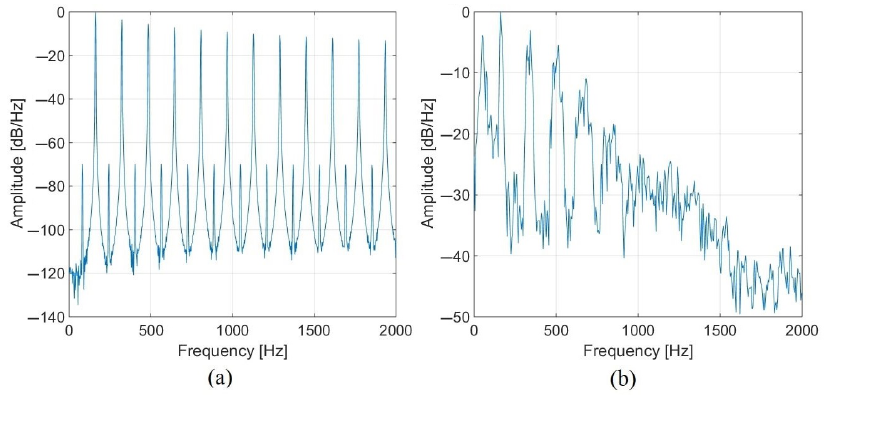
Figure 3. Power Spectral Densities of ( a ) the simulated drone signal provided by the model and ( b ) the real drone signal, both with f 0 = 80.6 Hz and f bp = 161.2